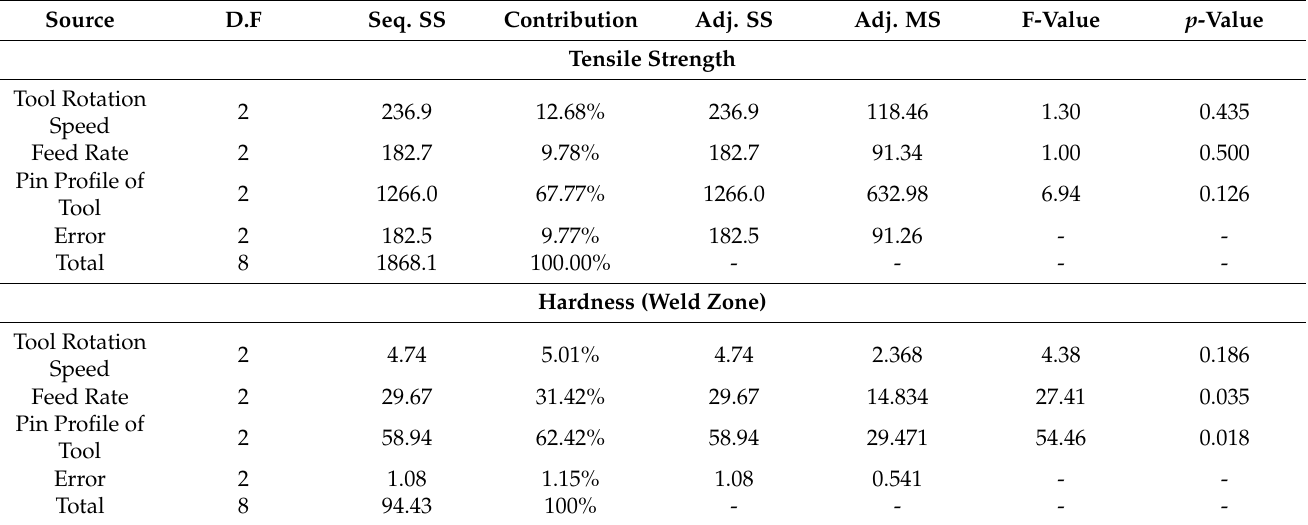
Table 6. ANOVA table for tensile strength and hardness.